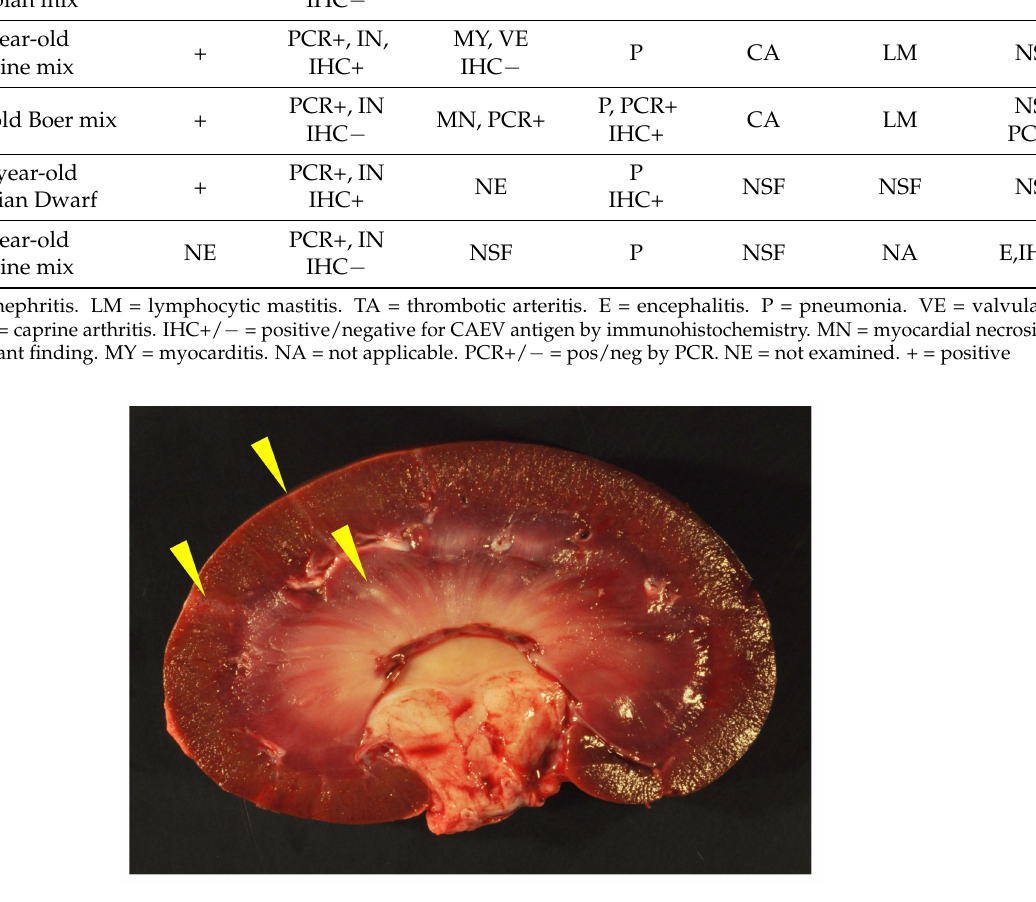
Figure 1. Gross image of kidney, goat D. Pale, linear radiating streaks are evident in the renal cortex and medulla (interstitial nephritis and fibrosis, yellow